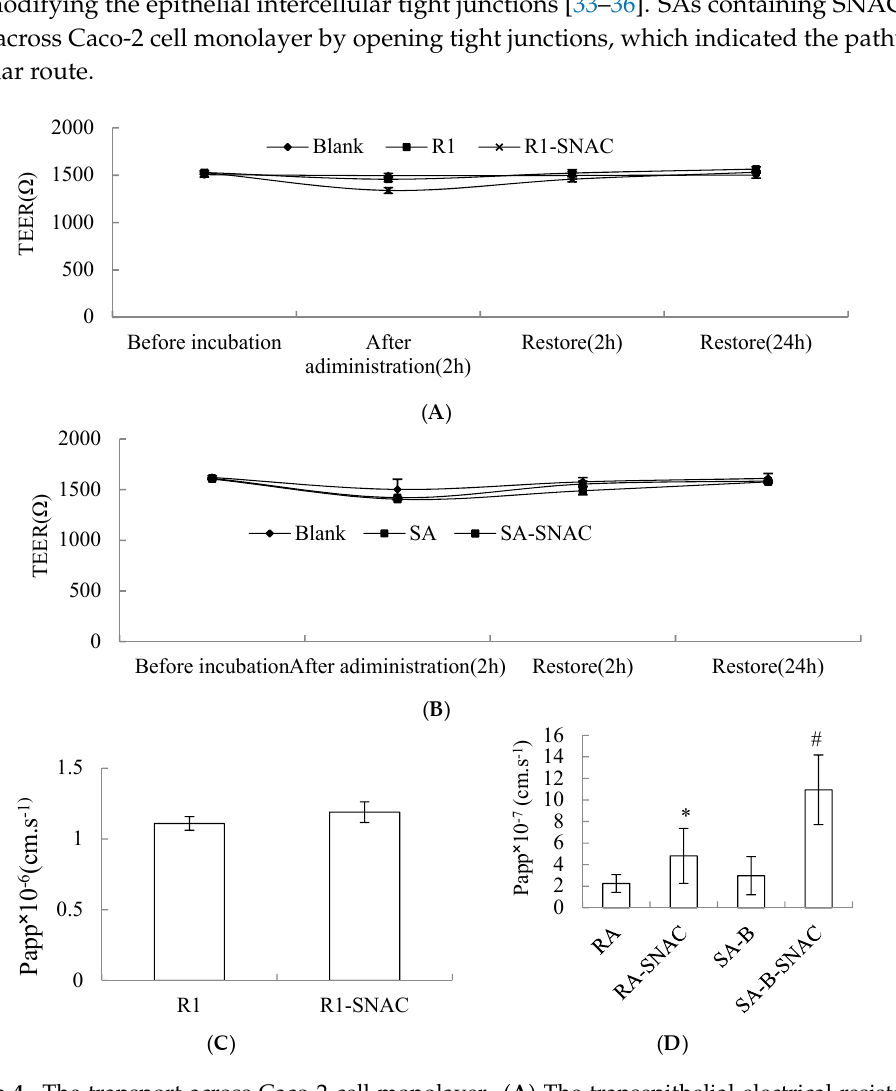
Figure 4. The transport across Caco-2 cell monolayer. ( A ) The transepithelial electrical resistance (TEER) change of Caco-2 cell monolayer treated with notoginsenoside R1 (R1) and R1 containing Sodium N-[8-(2-hydroxybenzoyl)amino]caprylate (SNAC). ( B ) TEER change of Caco-2 cell monolayer treated with salvianolic acids (SAs) and SAs containing SNAC. ( C ) Papp of R1 transport across Caco-2 cell monolayer. ( D ) Papp of rosmarinic acid (RA) and salvianolic acid B (SA-B) of SAs transport across Caco-2 cell monolayer. Values were represented as mean ± SD ( n = 3, each group). * p < 0.05 vs. RA group. # p < 0.05 vs. SA-B group. Note: 200 µ g · mL − 1 for R1; 50 µ g · mL − 1 for SAs; R1 or SAs: SNAC